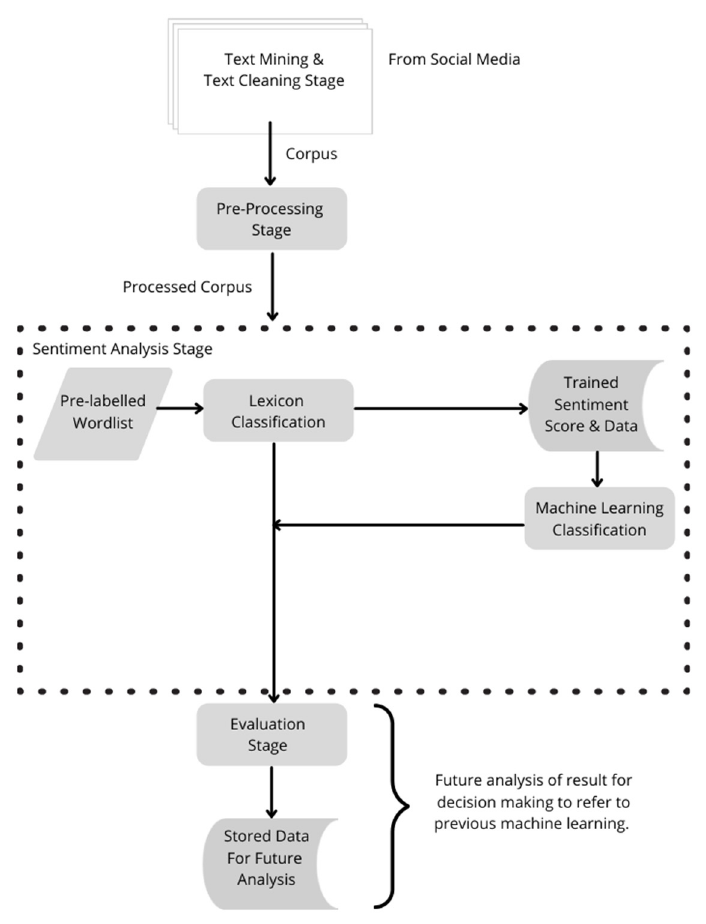
Figure 2. Proposed Framework.